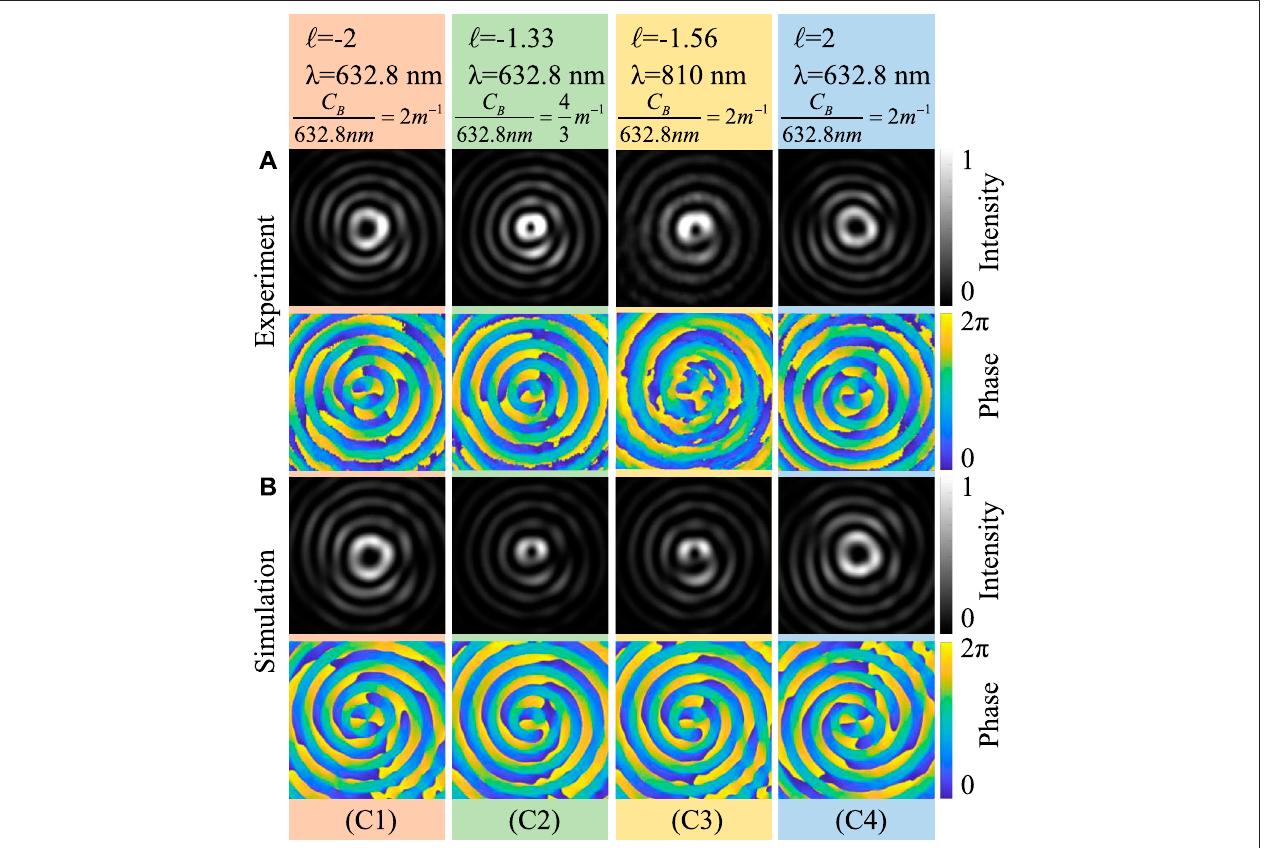
FIGURE 4 | Intensity and phase patterns of the AVB generated by different parameters of spiral axicon at z = 1 m. (A) Experimental results; (B) simulation results. The results of the clockwise spiral axicon whose parmeters are set to (C1) λ = 632.8 nm, C /632.8 nm =2 m − 1 ; (C2) λ = 632.8 nm, C /632.8 nm = 4/3 m − 1 ; (C3) λ = 810 nm, C /632.8 nm=2 m − 1 .(C4)Theresultofthecounterclockwisespiralaxiconwhoseparametersaresetto λ =632.8nm, C /632.8 nm=2 m − 1 .Thetopofthe fi gure is marked with the PLTC l of the corresponding propagation distance z calculated by Eq. 2